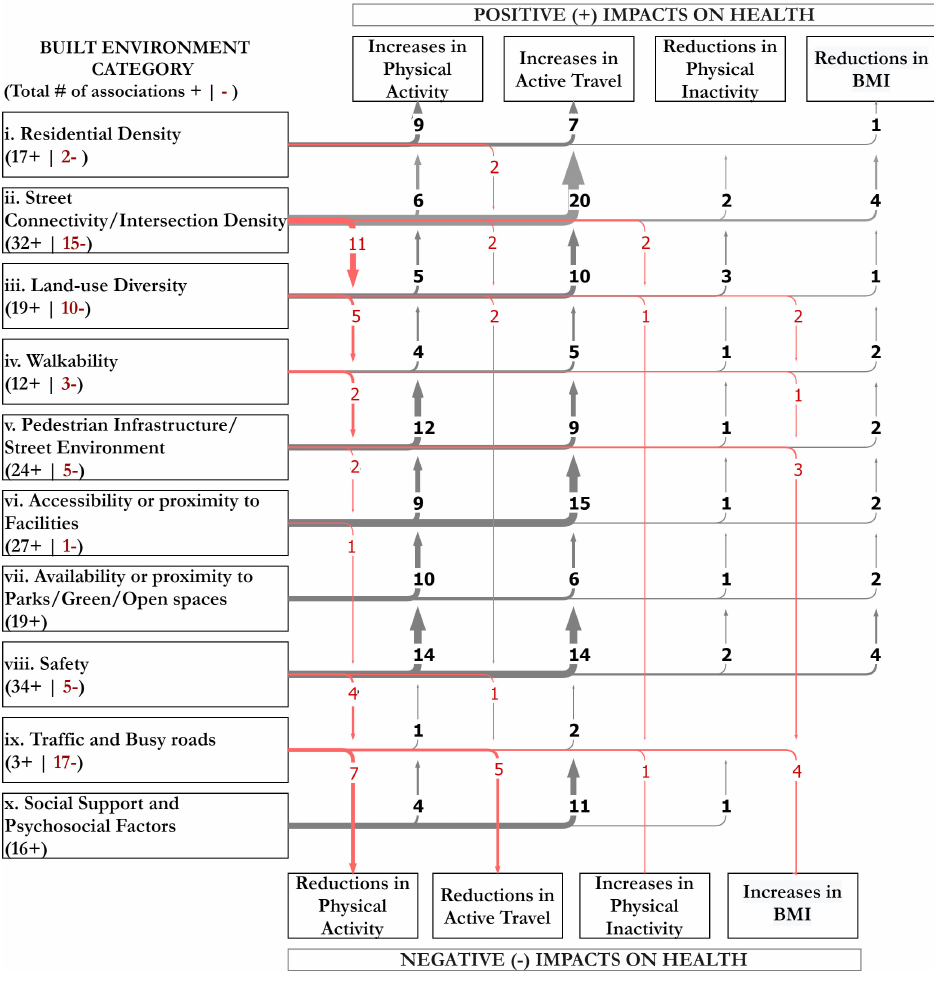
Figure 3. Built environment categories and interaction effect on health mediators and health outcomes. The arrow’s width and numbering indicate the number of studies that found the specific association. The number in the brackets under each BE category indicate the total number of studies that found associations between the BE attribute and positive (+) or negative ( − ) health